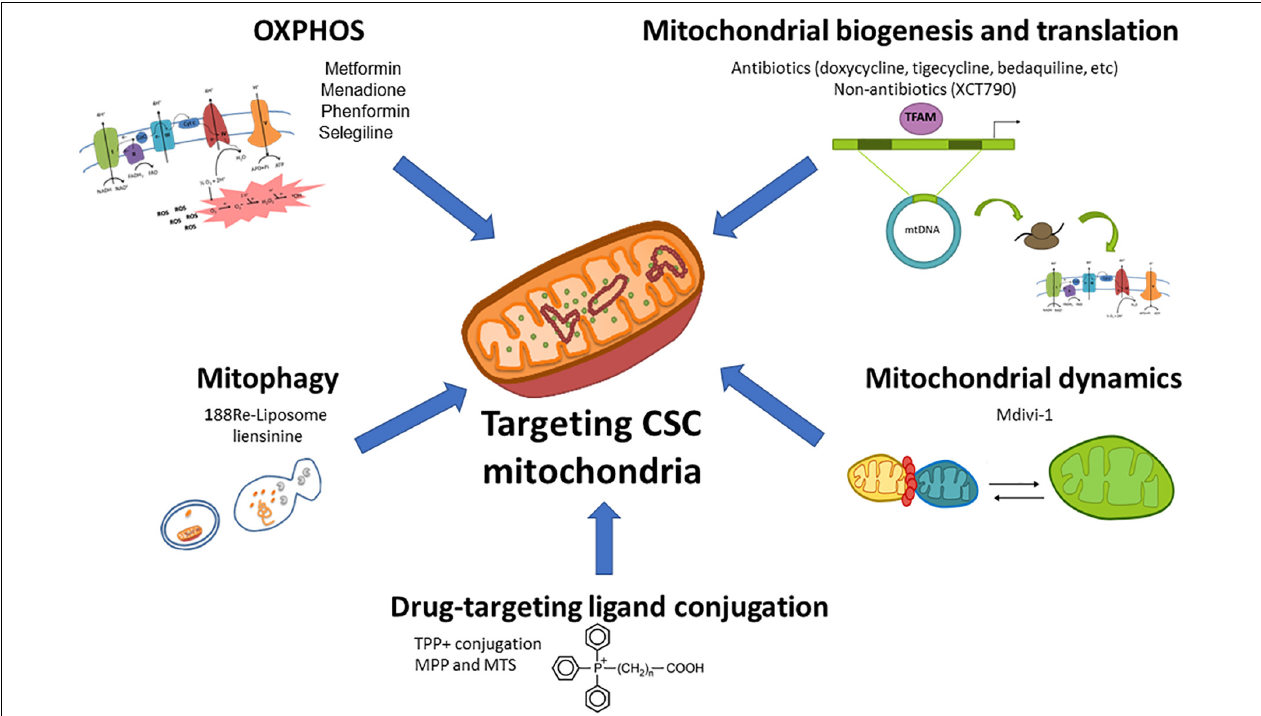
FIGURE 1 | Therapeutic targeting of mitochondrial metabolism in CSCs. Different aspects of the mitochondrial metabolism can be approached to target CSCs: (1) oxidative phosphorylation (OxPhos) can be impaired by ETC inhibitors such as the antidiabetic drugs metformin or phenformin, the reactive oxygen species (ROS) inductor and complex I inhibitor menadione, or the anti-Parkinson compound selegiline; (2) Mitochondrial biogenesis and translation can be targeted by FDA-approved antibiotics such as doxycycline, tigecycline, bedaquiline among others, or non-antibiotic inhibitors; (3) Mitochondrial dynamics can be disrupted by the mitochondrial division inhibitor Mdivi-1; (4) The blockage of mitophagy, an essential mitochondrial quality control system, with nanomedicines such as 188Re-liposome or the inhibitor liensinine may affect CSCs functions; (5) The use of nanocarriers (lipophilic cations, peptides and nanoparticles) conjugated with chemotherapeutics and small drugs may be used for a selective delivery of drugs in mitochondria.